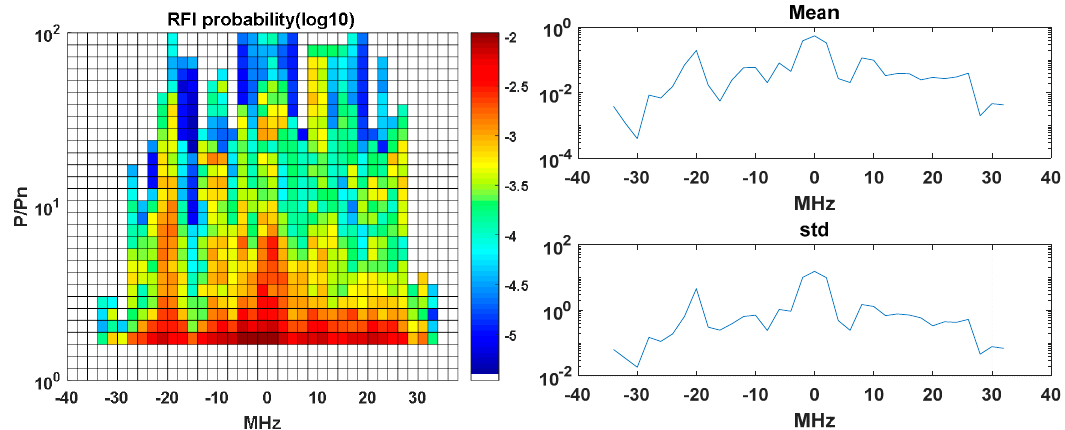
Figure A7. Left: cumulated histograms ( right ) of RFI power distributions with frequency, normalized to S1 noise, estimated by processing data from all-Europe. Vertical scale is probability in log10. Right: Plots of average ( above ) and standard deviation ( below ) of the RFI mean normalized power for each frequency bin.